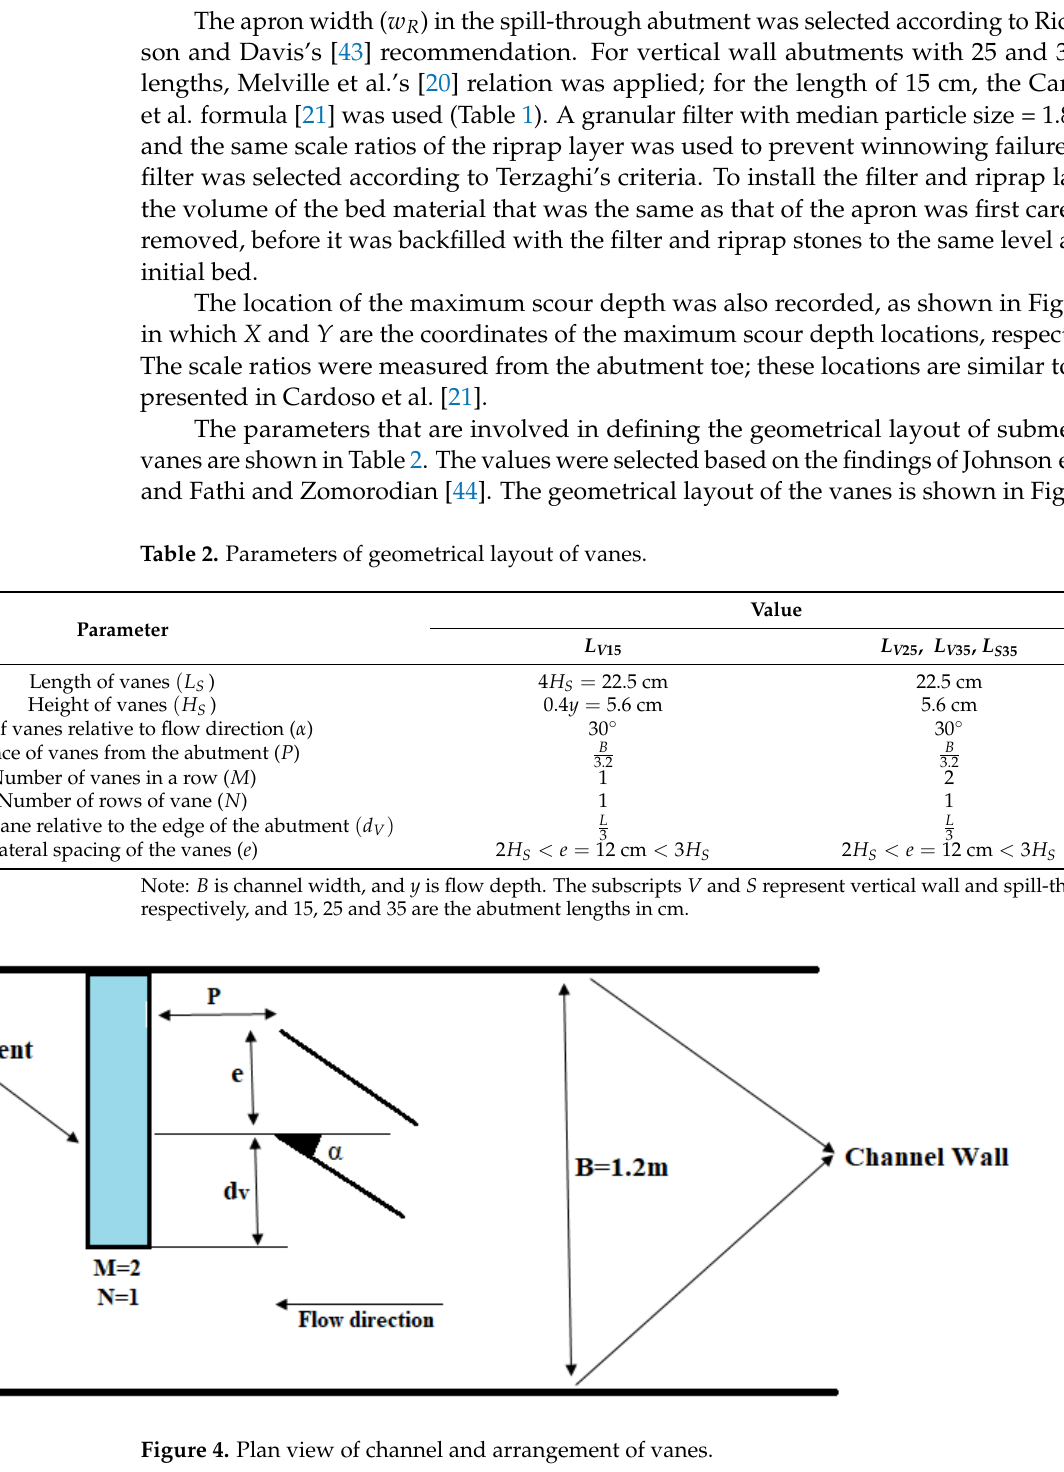
Table 1. Characteristics of riprap stones.